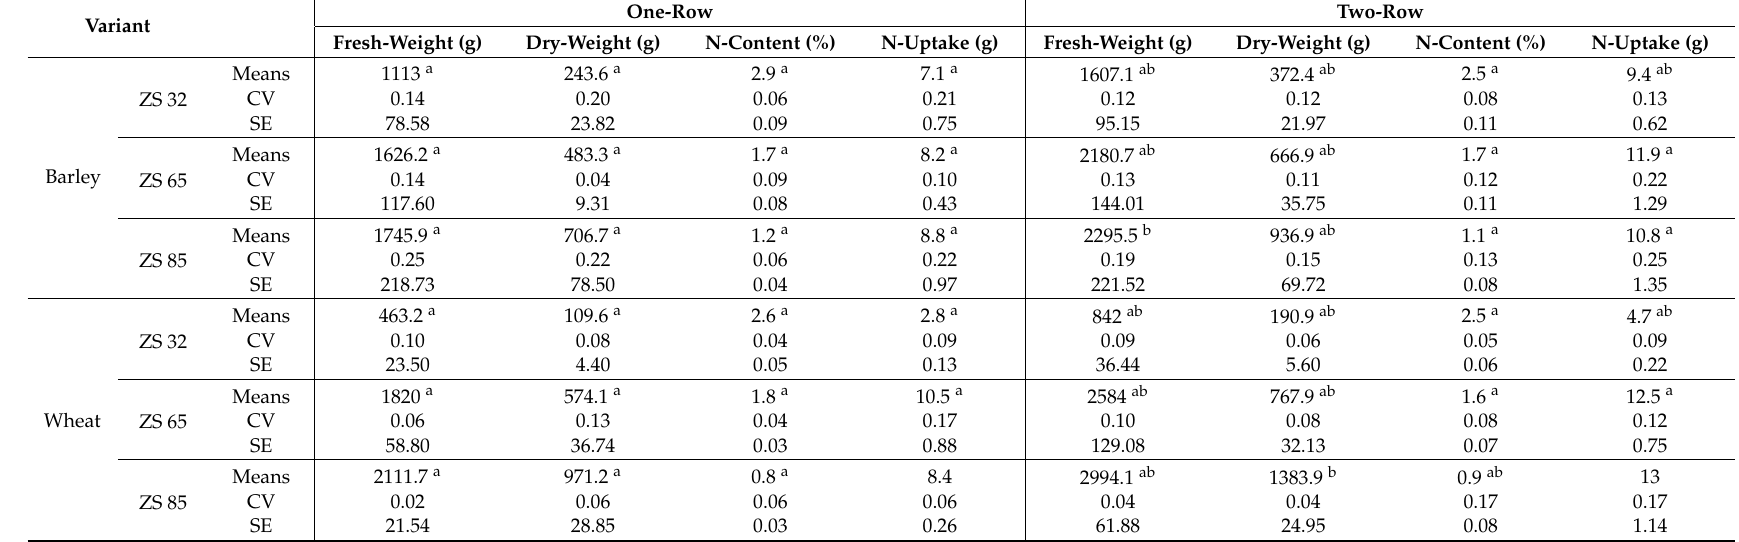
Table 1. Destructively-assessed values of aboveground plant fresh and dry weight, N content, and aboveground nitrogen uptake of wheat and barley plants as obtained from different plot designs. The plot designs included 1, 2, 3, 4, or 10 rows, and samples were collected from plants at three different stages of development (ZS 32, 65, and 85). Coefficients of variation, standard errors of the means, and plant parameters per plot for the different row designs are indicated, with each value representing the average of four replicates. Rankings are derived from Tukey’s HSD-Test, are indicated at p ≤ 0.05 indicating differences within rows. Different letters (a,b,c,d) denote significant